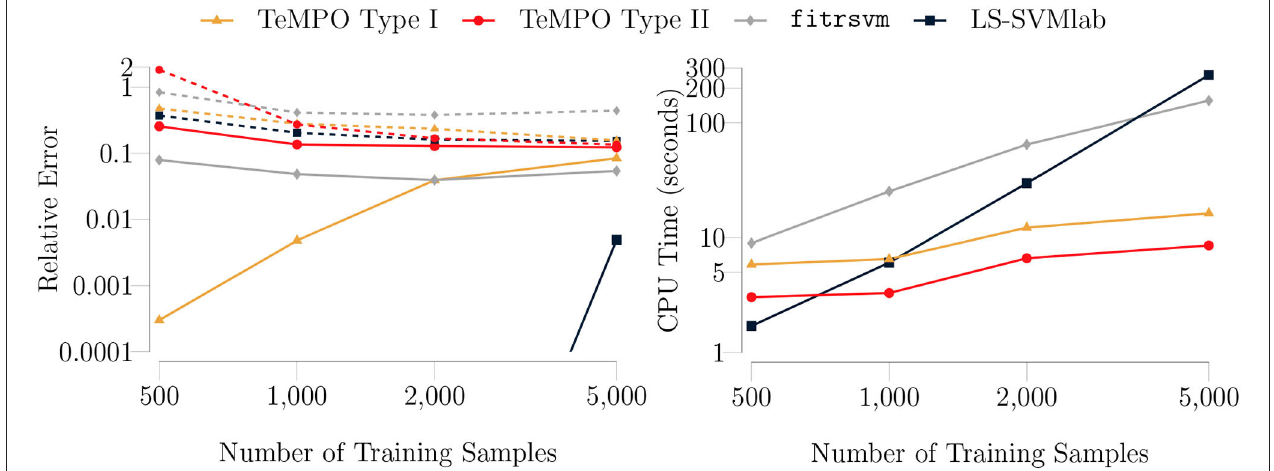
FIGURE 7 | (Left) The median test (dashed lines) and training (solid lines) errors of SVMs with polynomial kernel, the type I and type II model for a rank-8 function given as in Equation (29) in the presence of SNR 20 dB Gaussian noise as a function of the number of training samples for 100 trials. The batch size is equal to 10% of the training set size. The maximum number of GN iterations is set to 5 for the type I and type II model. Specifically, for the SVMs, the built-in Matlab routine fitrsvm and LS-SVMlab toolbox were used to obtain the results. The relative errors of LS-SVMLab for the sample sizes 500, 1,000, and 2,000 are 1.6e − 6, 2.2e − 6 and 3.3e − 6, respectively. The presented algorithm generalizes better than fitrsvm in these experimental settings. (Right) The median CPU times (seconds) with the same setting. The computational complexity of our algorithm is linear in the problem size as expected, and it is faster than SVMs for numbers of training samples above 1,000. The figures are in a logarithmic scale on both the horizontal and vertical axes.